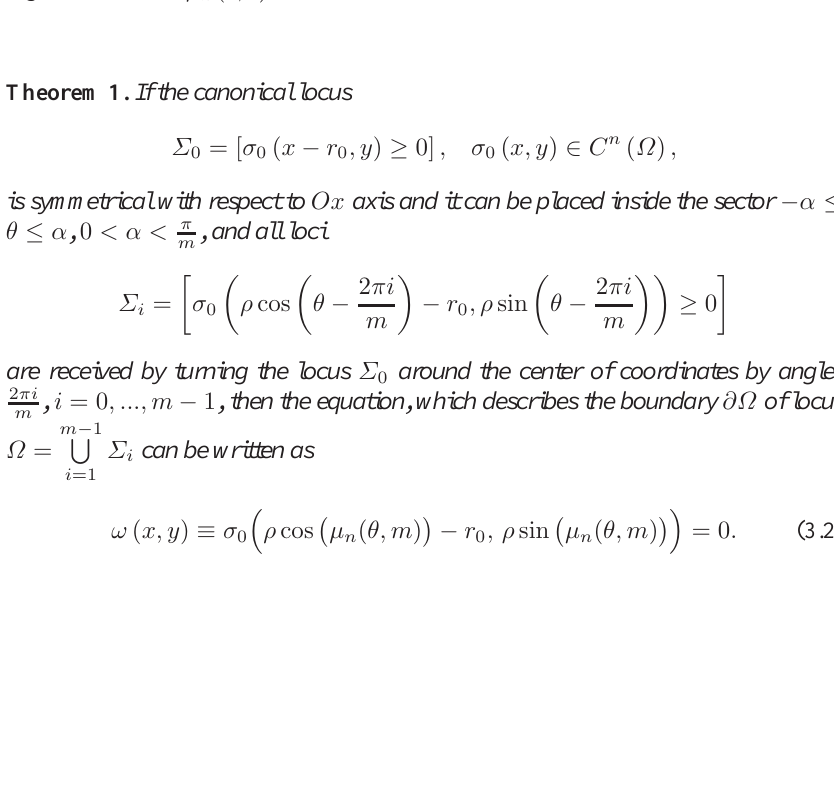
Figure 2. Function µ n ( θ, 3)